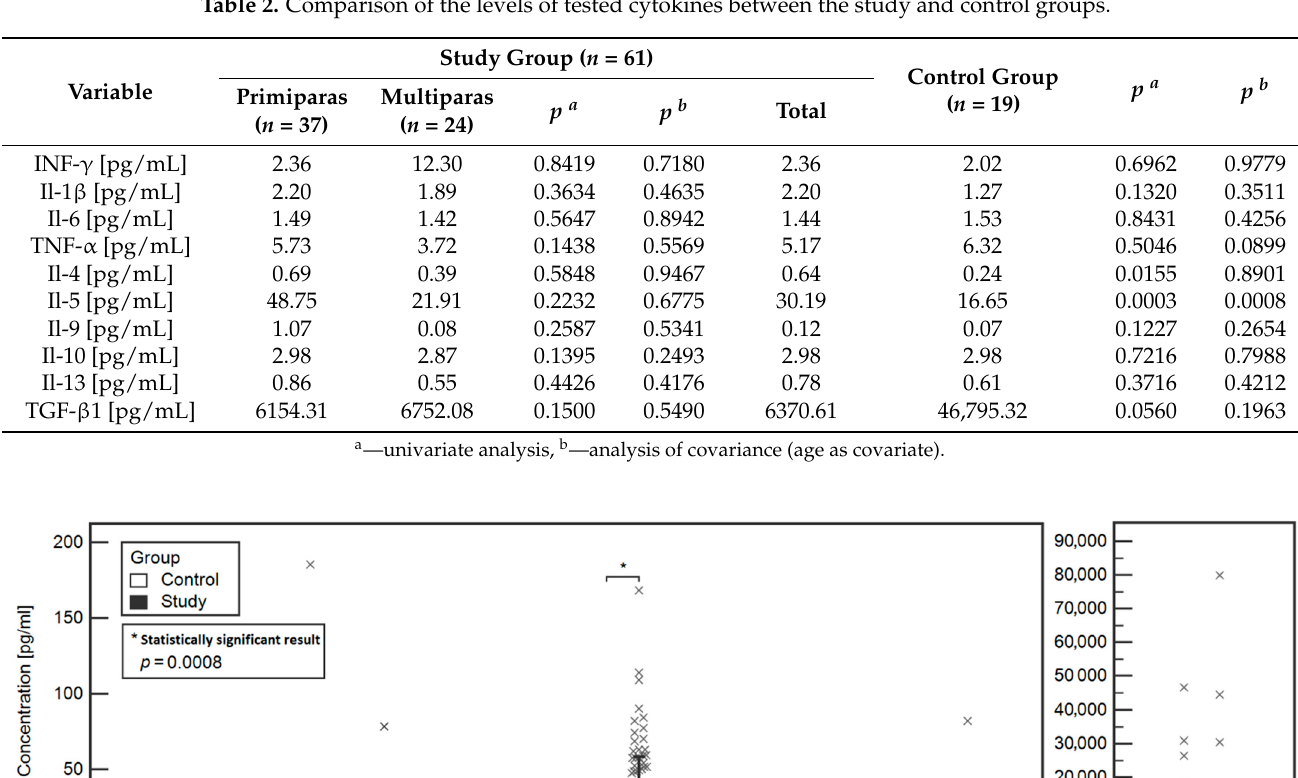
Table 2. Comparison of the levels of tested cytokines between the study and control groups.